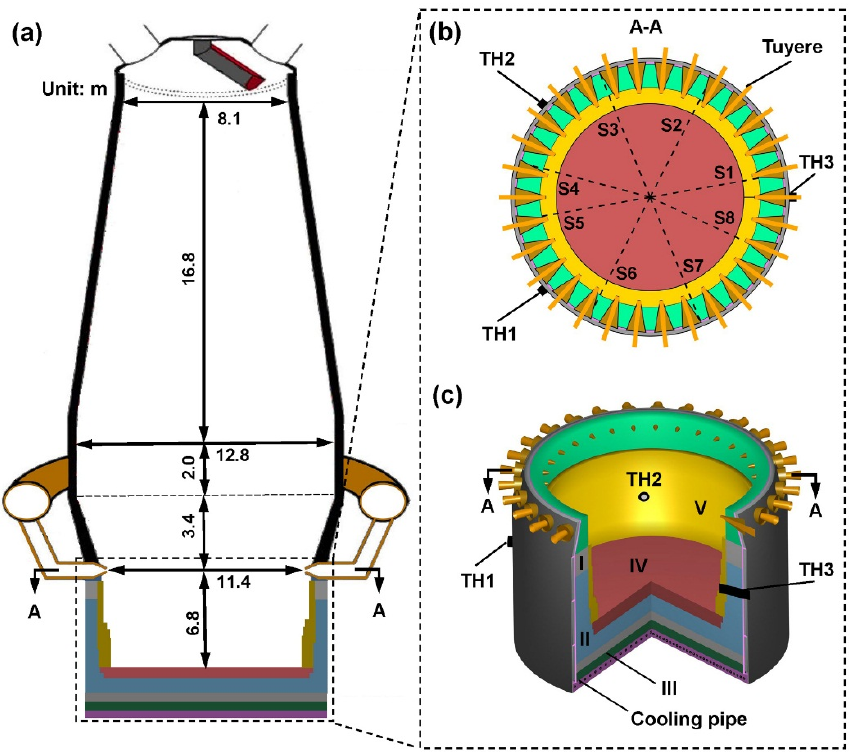
Figure 1. Schematic illustration of the blast furnace and its hearth: ( a ) sketch of the blast furnace with some key design parameters, ( b ) top-view from the horizontal cross-section at the tuyere level (i.e., A-A), and ( c ) detailed structure of the hearth in three dimensions.